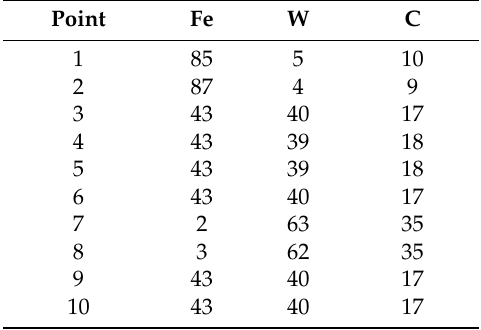
Table 2. The atomic percentage (at %) of WC p /iron matrix composites with different particle shape. Point